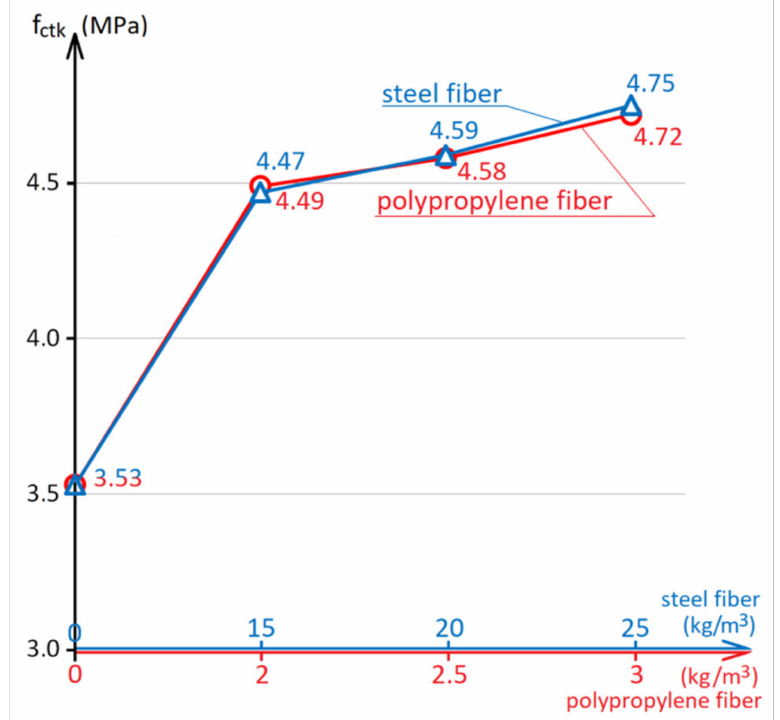
Figure 4. The influence of the steel and polypropylene fibers amount on the concrete flexural strength at the age of 28